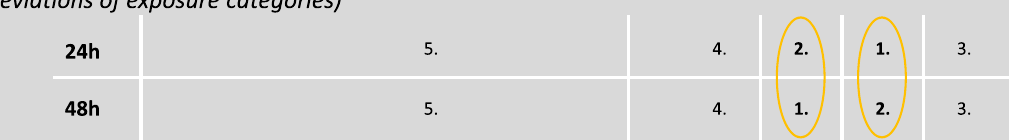
Figure 6. WNT3 results. Display of TaqMan assay arrangement on a schematic image of WNT3 (note: size ratio of exons to each other is not accurate), baselines and differential gene expression after 0.5 Gy and 4 Gy after 24 h and 48 h. At the bottom of the figure, the inter-individual variability is shown. The assay with the lowest sum of the standard deviation of the FCs over all dose categories is ranked 1st. Correspondingly the assay with the highest sum is ranked last. Starting with the baseline and working downwards, the assays meeting the criteria defined in the material and methods are circled. For illustration, the inter-individual variability of the TaqMan assays identified using the other criteria (baseline, dose dependency, time persistency) are circled in orange. The two encircled assays on the schematic image of WNT3 are the ones most suitable for biodosimetry purposes. Asterisks mark the best coverage assay. Data from only one donor, for the other two donors the assay was not detectable 1